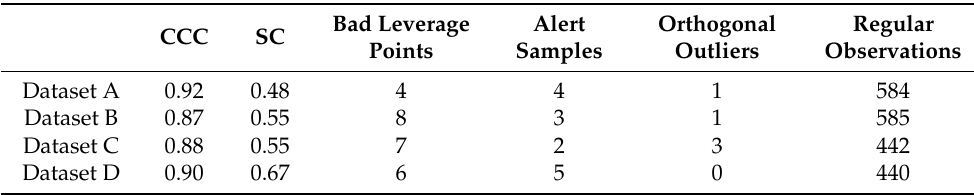
Table 4. Results obtained for each dataset. We highlight that, in Dataset C, the second cluster has seven samples instead of the expected six mislabeled samples. In the first analysis, one could think of an error in the clustering technique; in fact, the study of the degradation of the samples suggests that this sample shows a similar behavior with respect to the Normalized Unscaled Standard Error (NUSE) graph as the mislabeled samples of the cluster in which it was inserted. Bad Leverage Alert Orthogonal Regular CCC SC Points Samples Outliers Observations Dataset A